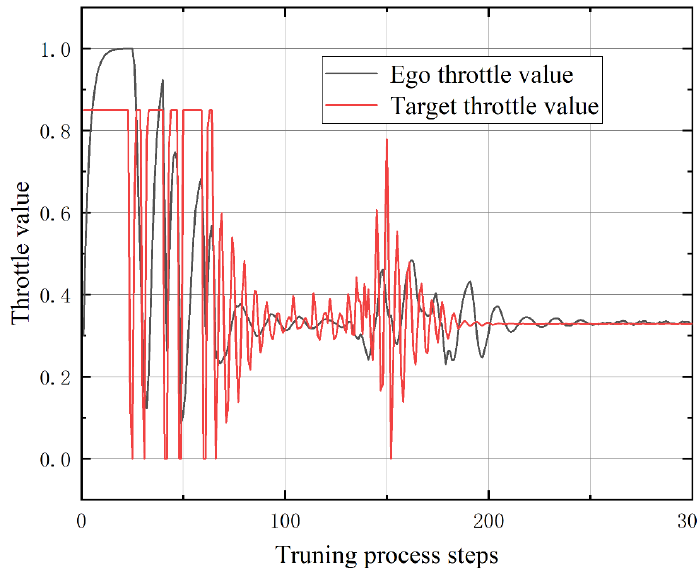
Figure 8. Comparison between throttle value of the ego and target in the turning process.